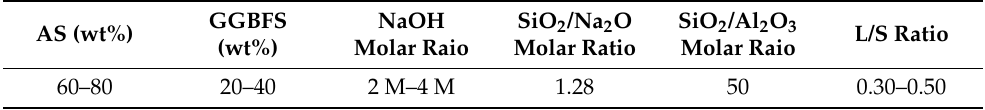
Table 4. The preparation parameter of AG geopolymer mortar.